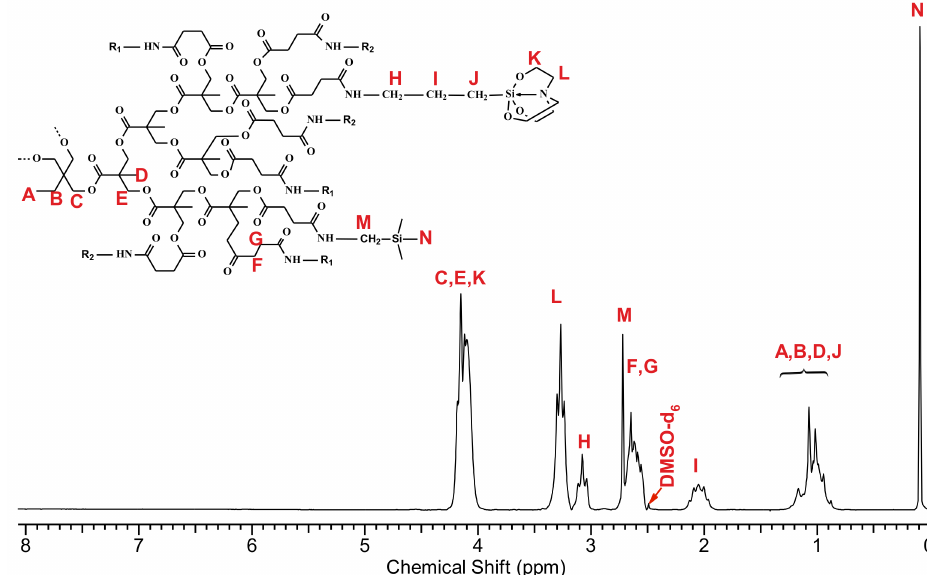
Figure 7. 1H-NMR spectrum and schematic architecture of silatrane-containing Boltorn H40.